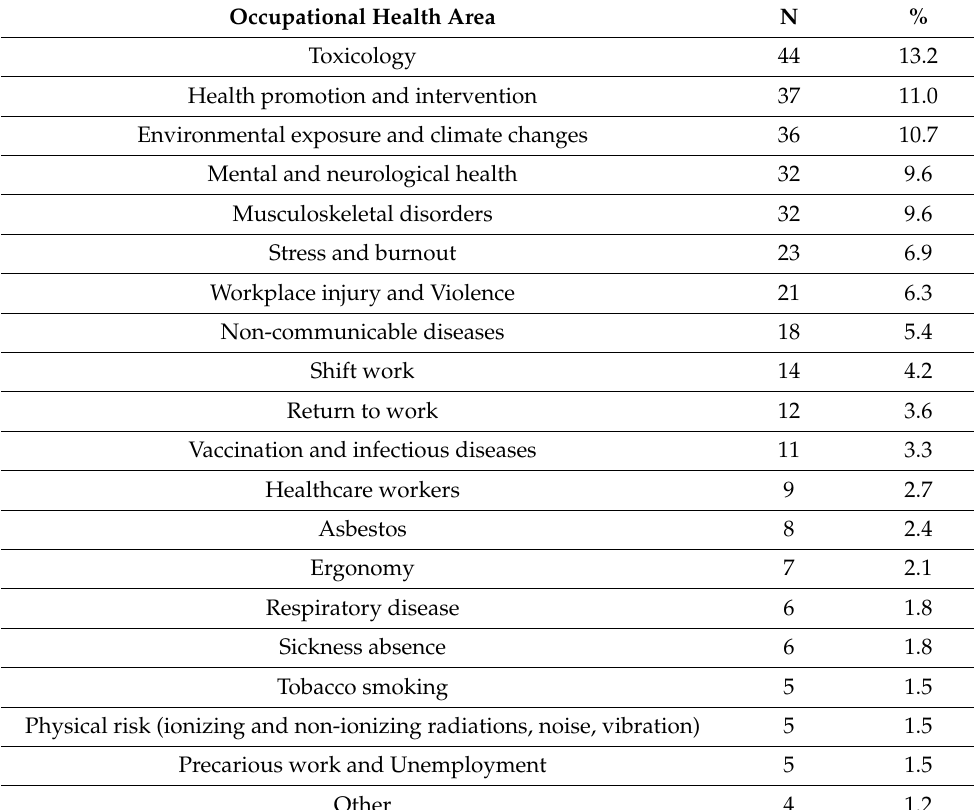
Table 1. Occupational health areas covered by the systematic reviews.